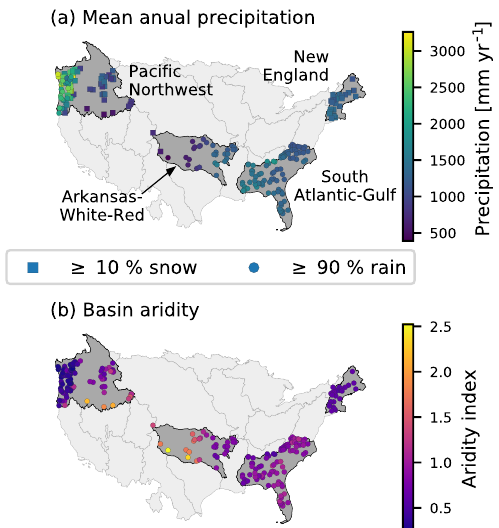
Figure 5. Overview of the location of the four hydrological units from the CAMELS data set used in this study, including all their basins. Panel (a) shows the mean annual precipitation of each basin, whereas the type of marker symbolizes the snow influence of the basin. Panel (b) shows the aridity index of each basin, calculated as PET/P (see Addor et al., 2017a).